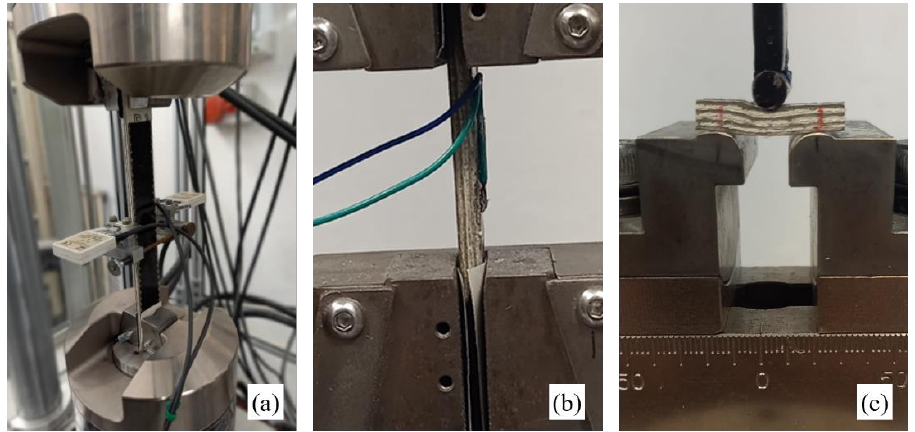
Figure 5. ( a ) Tensile test, ( b ) compression test, and ( c ) ILSS